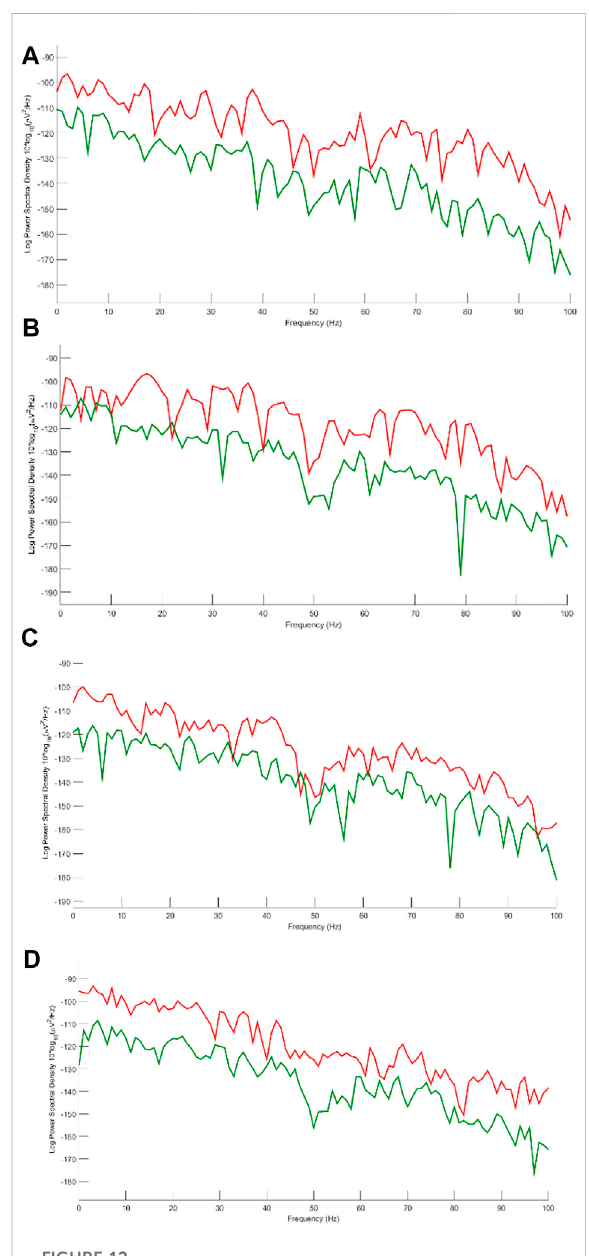
FIGURE 12 Power spectrum for (A) Fp1, (B) Fp2, (C) F8 and (D) T7. Red and green lines correspond to EEGs before and after applying artifact elimination